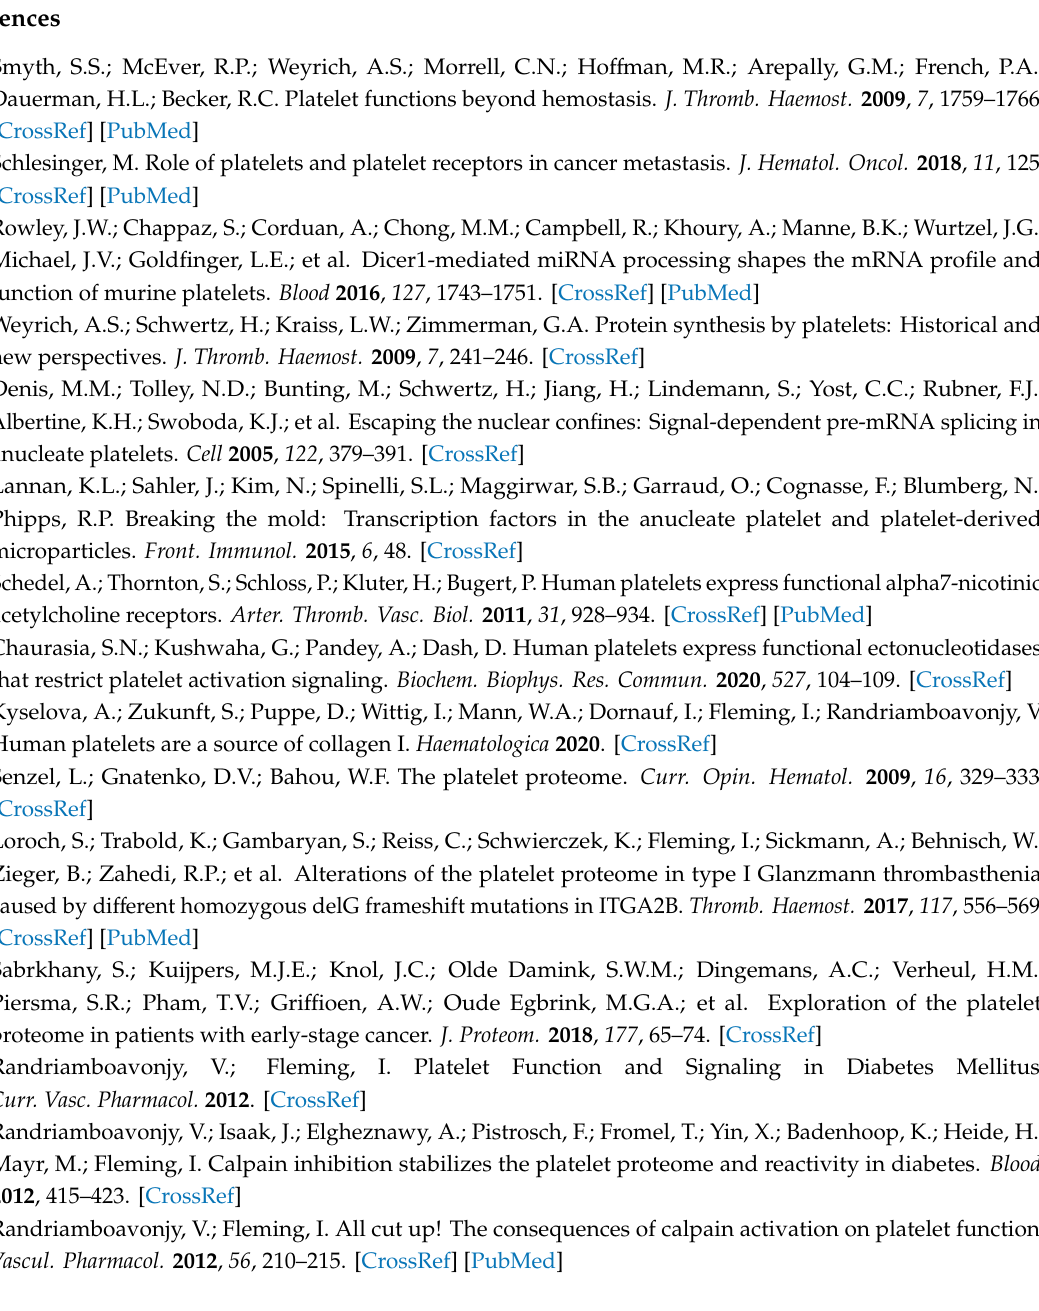
Figure S1: Representative blot showing the levels of CCNY and ubiquitin in triton soluble vs triton insoluble fraction in resting platelets and after stimulation with thrombin (Thr, 1 U / mL, 10 min), the thromboxane A2 analogue U46619 (U46, 100 nmol / L, 10 min) or ADP (1 µ mol / L, 10 min), Figure S2: Body weight of wild-type and Ccny - / - male (left panel) and female (right panel)mice; n = 4–9 (Unpaired t -test),*** p < 0.005., Table S1, Table S2: Blood counts in wild-type and Ccny - / -